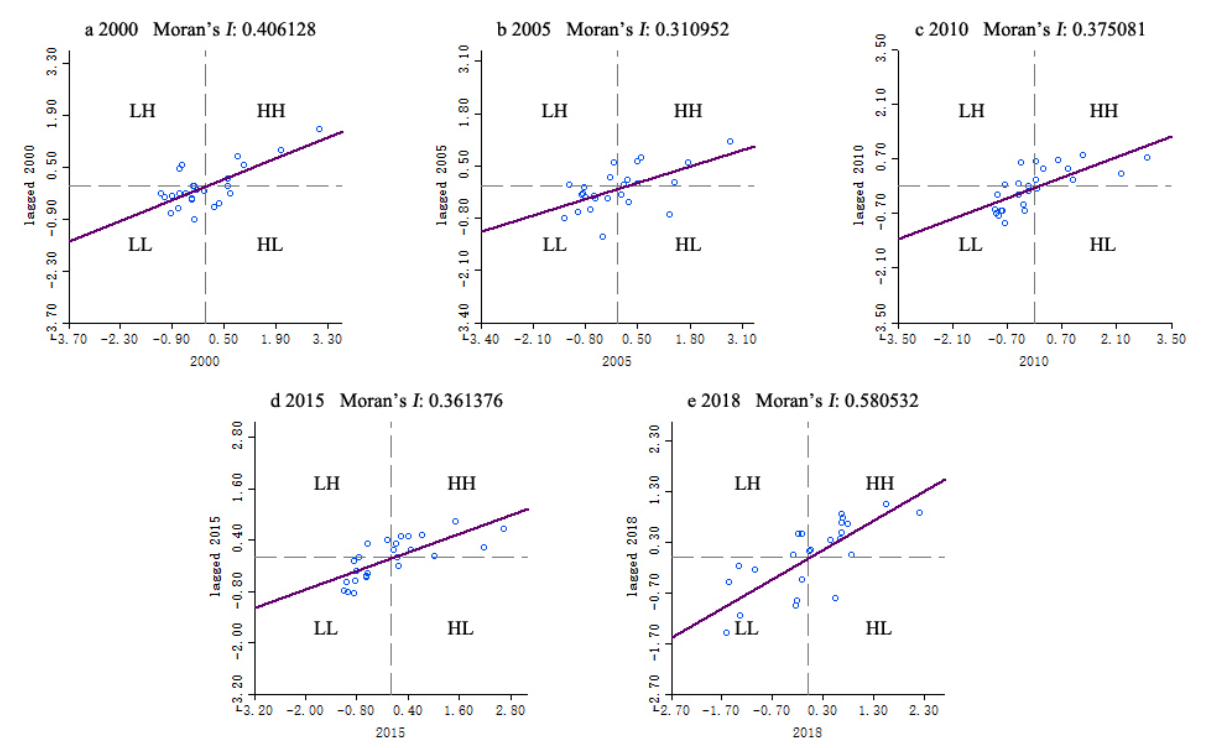
Figure 6. Moran scatter plot of TESI in Huanggang Dabieshan UGGp from 2000 to 2018. HH, High-High agglomeration; HL, High-Low agglomeration; LL, Low-Low agglomeration; LH, Low- High agglomeration.